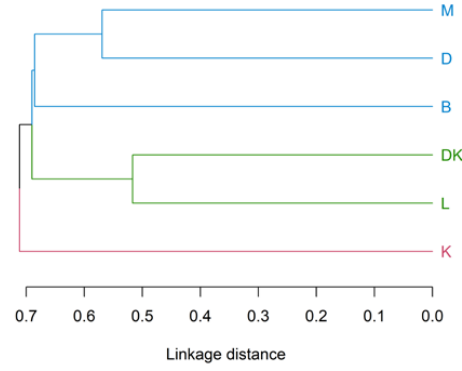
Figure 3. Dendrogram plot for sites. M—Moszne, D— Długie, B — Bikcze, DK — Dekowina, L — Lubowierz, K — Karaśne .